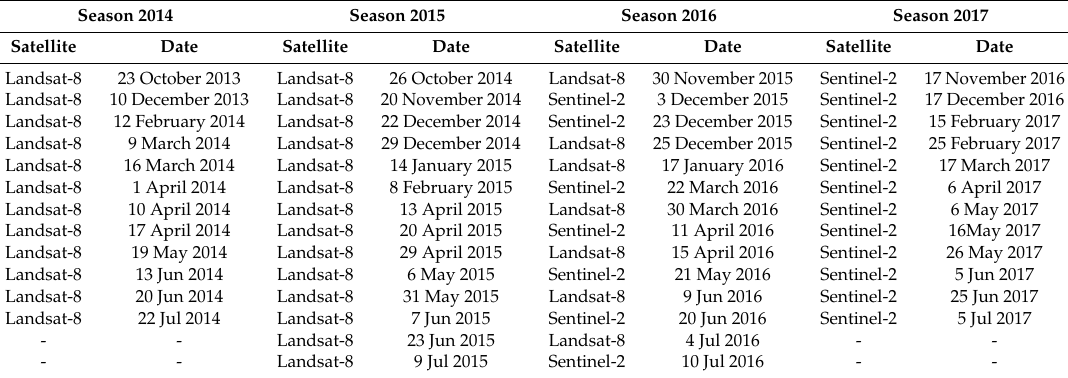
Table 1. Characteristics of the satellite remote sensing